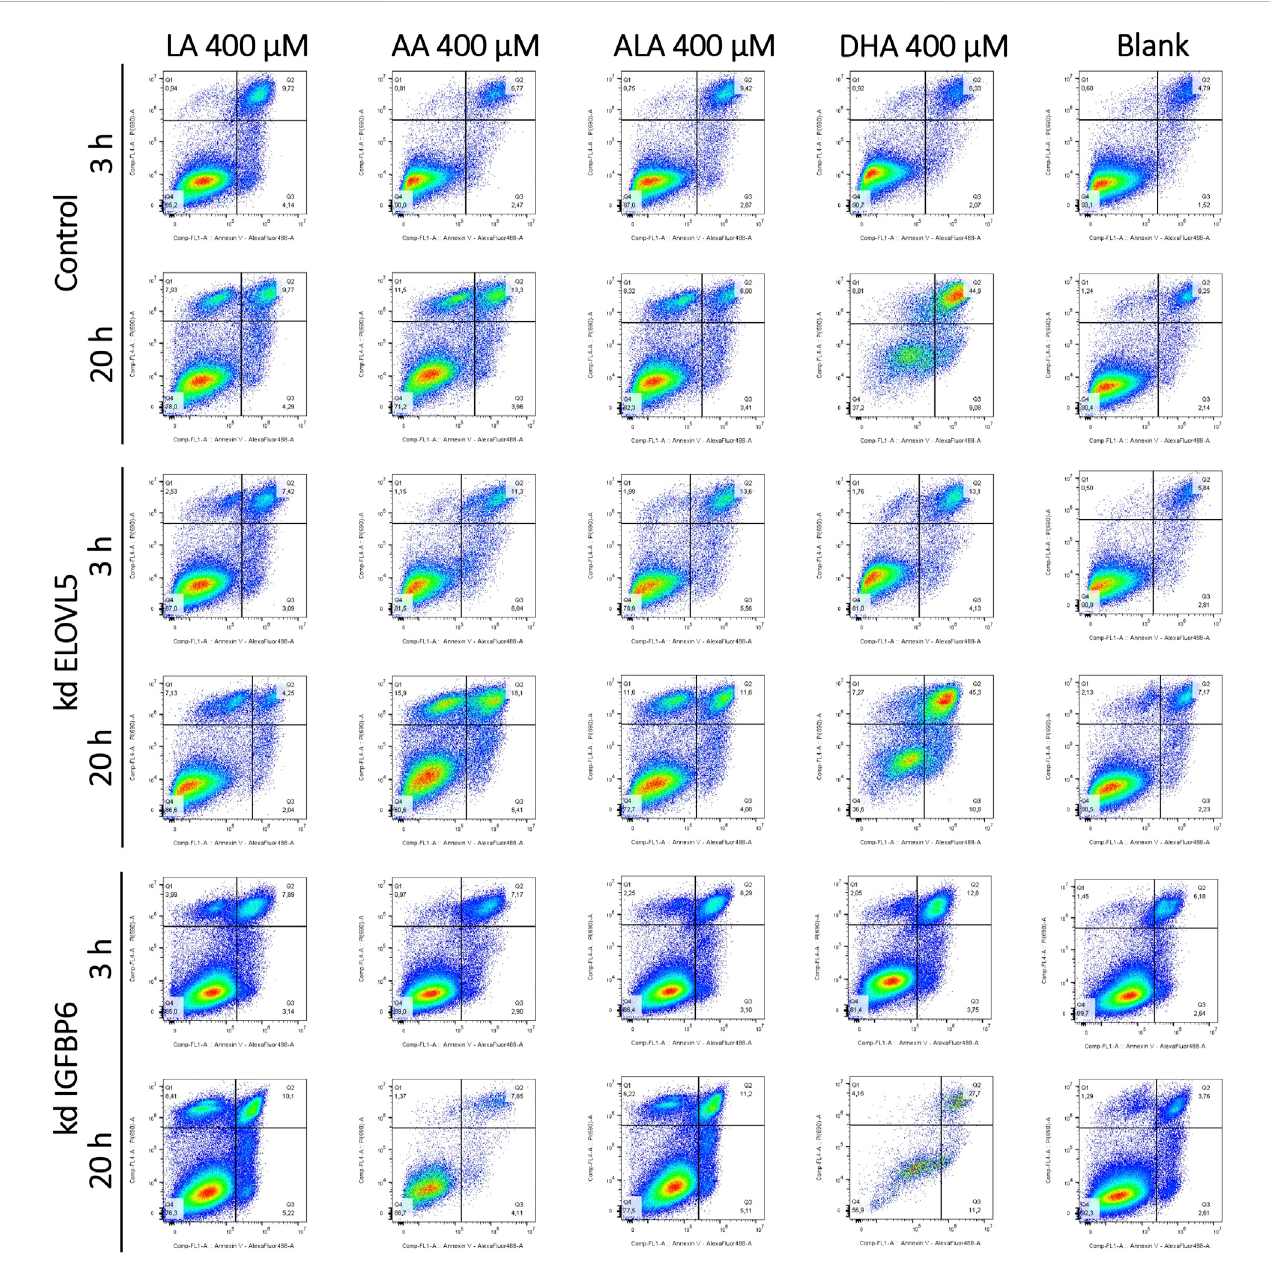
Effect of various LC-PUFAs on the activation of apoptosis in MDA-MB-231 cells. Two-dimensional plots of the integral fl uorescence intensity of the annexin V conjugate with Alexa Fluor 488 dye (horizontal axis), and the integral fl uorescence intensity of propidium iodide (vertical axis) in the cells with the knockdown of ELOVL5 or IGFBP6 genes, as well as in controls